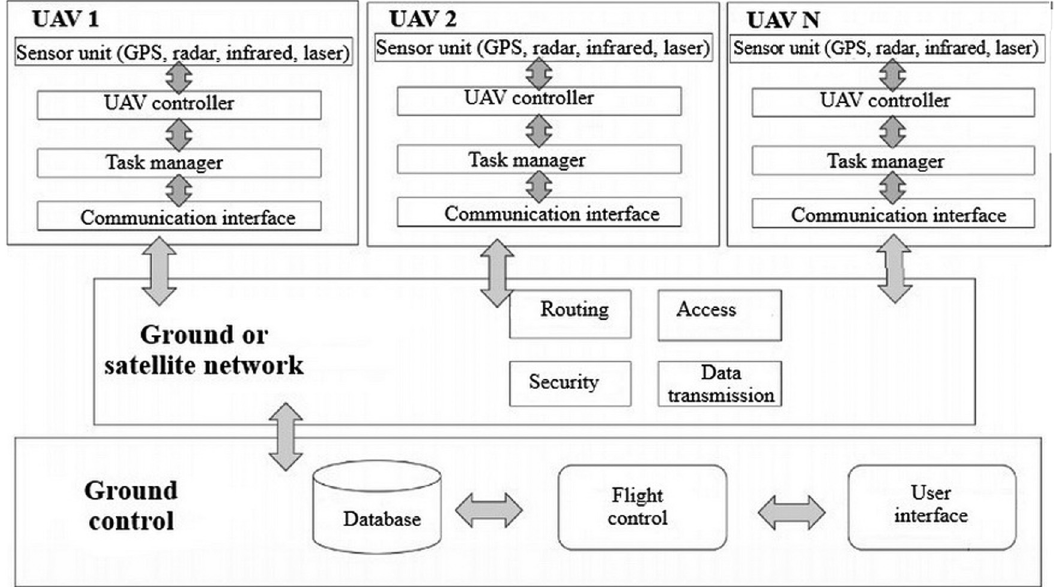
Figure 2: Scheme of the UAV signal processing architecture [ 33 ]